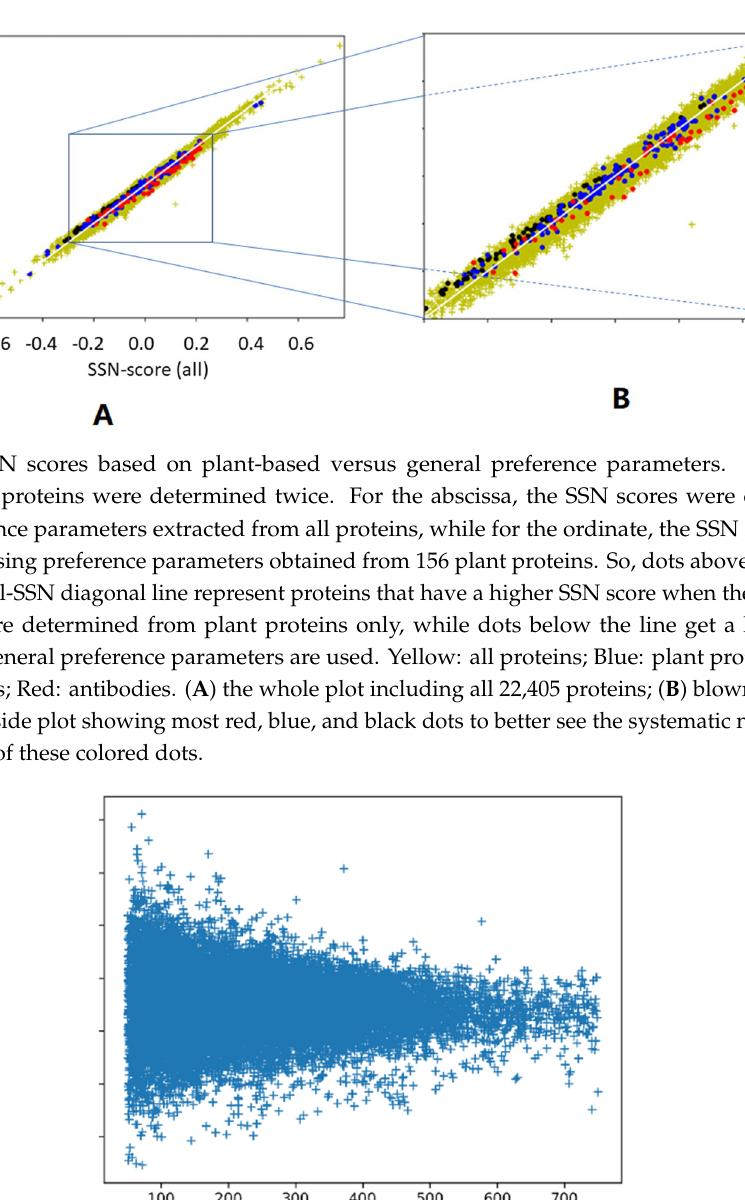
Figure 8. SSN scores as function of protein length.